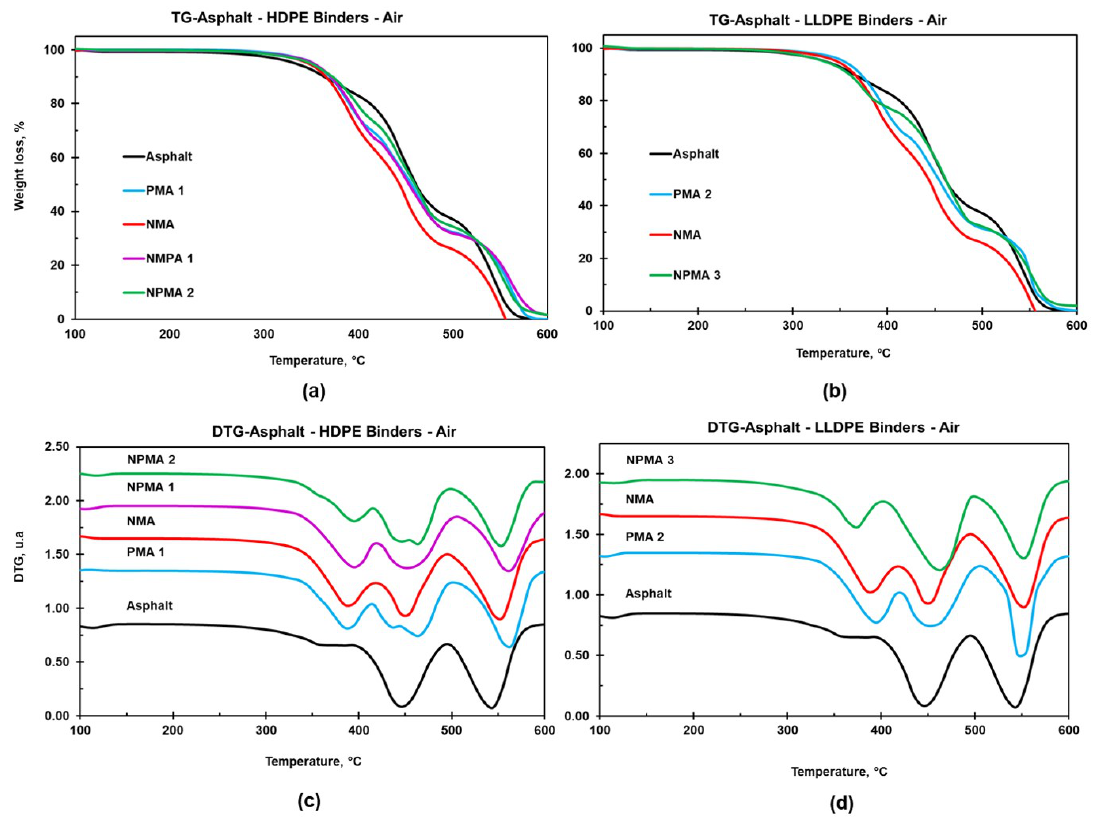
Fig. 3. TGA results under air atmosphere: (a) TGA curves of asphalt modified with HDPE; (b) TGA curves of asphalt mixtures modified with LLDPE; (c) DTG curves for asphalt modified with HDPE; (d) DTG curves for asphalt mixtures by LLDPE.